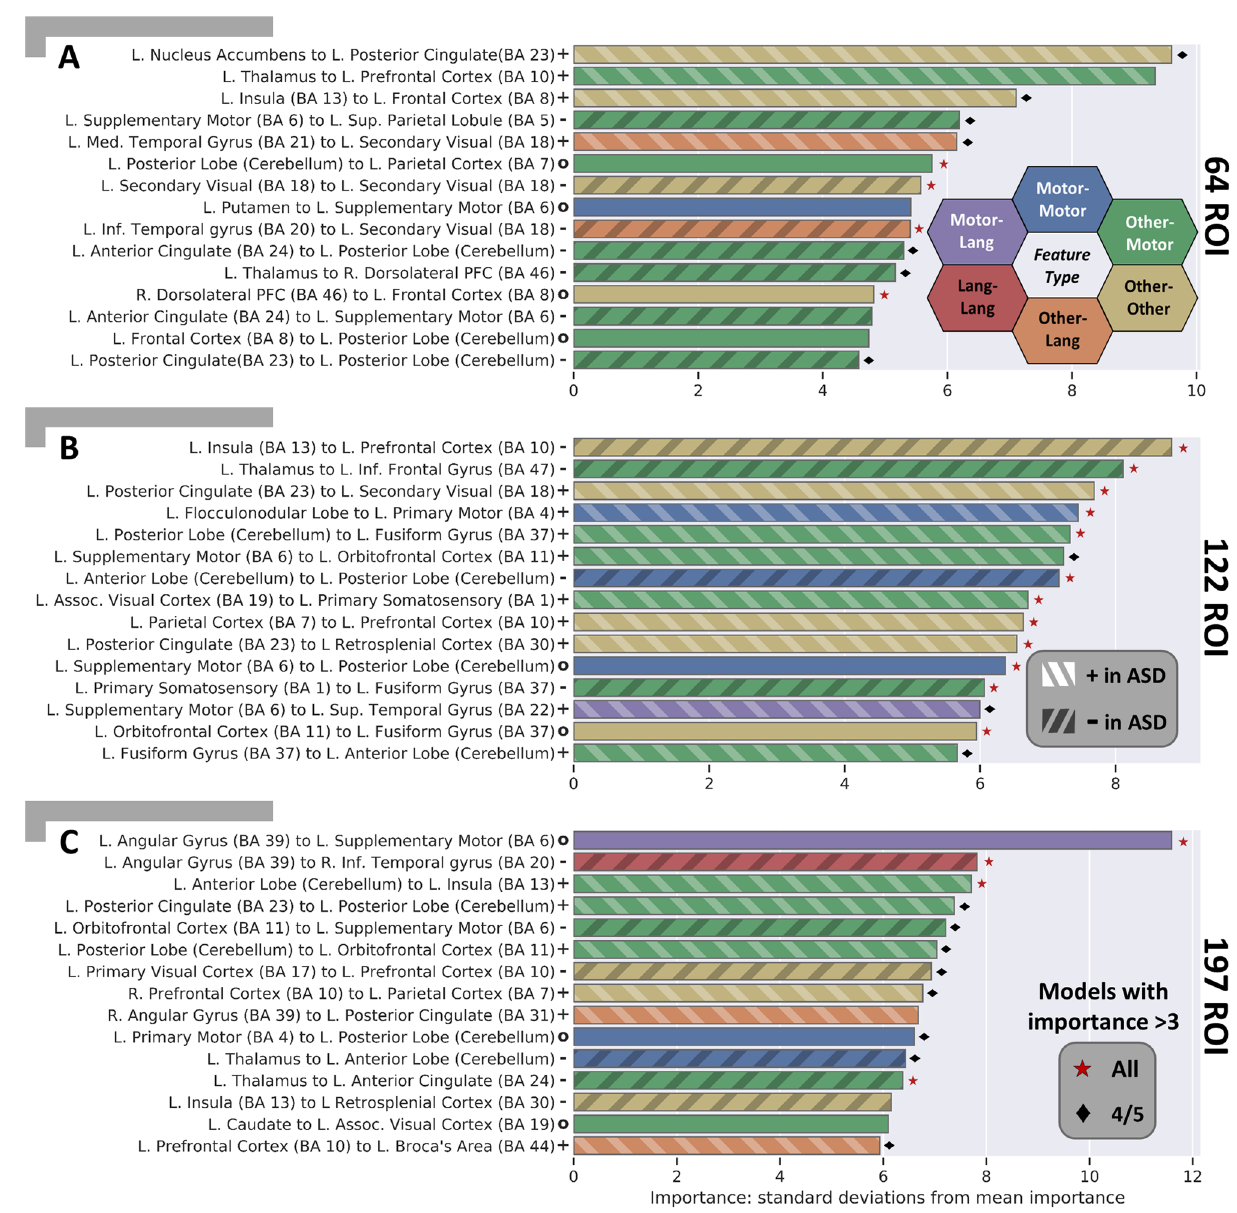
Figure 3. Important features learned by top performing models for ASD diagnosis at each level of BASC atlas (ROI) granularity with coarse-grained atlas ( A ), medium-grained ( B ), and fine-grained ( C ). Each feature captures the functional connectivity between two brain regions and is given a distinct color based on the function of the region pair. Connections between sensorimotor ROIs are shown in blue, while connections between language ROIs are in red. Connections between regions that are neither motor nor language are in yellow. A connection between language (red) and motor (blue) ROIs is shown with an intermediate hue (i.e. purple) and similarly for other region function combinations. For each important feature, an independent sample two tailed t test testing for a difference in that feature amongst ASD subjects vs. TD subjects was performed. Those that were found to be significant at p ≤ 0 . 05 were additionally marked as increased in ASD (+) and hashed lighter or decreased in ASD (−) and hashed darker. Those connections that were found not to be significantly different in ASD vs. TD were marked with a ( o ) and are presumed to be important features only in a multivariate combination with other features. The corresponding p-values (FDR corrected at 0 . 01) for the calculated PFI of the median model are significant for all displayed features. This indicates the importances are greater than what would be found by chance due to the random permutations in the PFI approach alone. For each feature, if all 5 of the interrogated models had a z-scored importance ≥ 3, the median feature is marked with a red star, if four had a z-scored importance ≥ 3, the median feature is marked with a black diamond 63,64